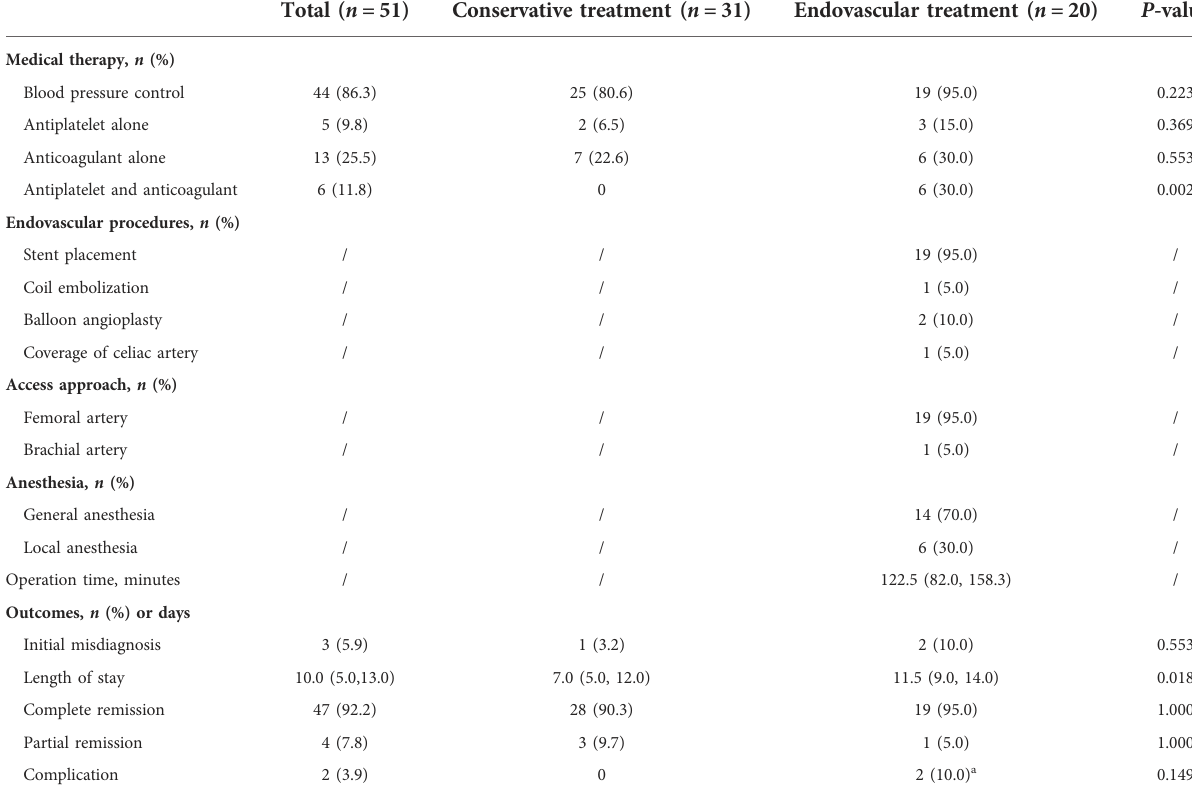
TABLE 2 Treatments and outcomes of the patients with symptomatic SICAD in